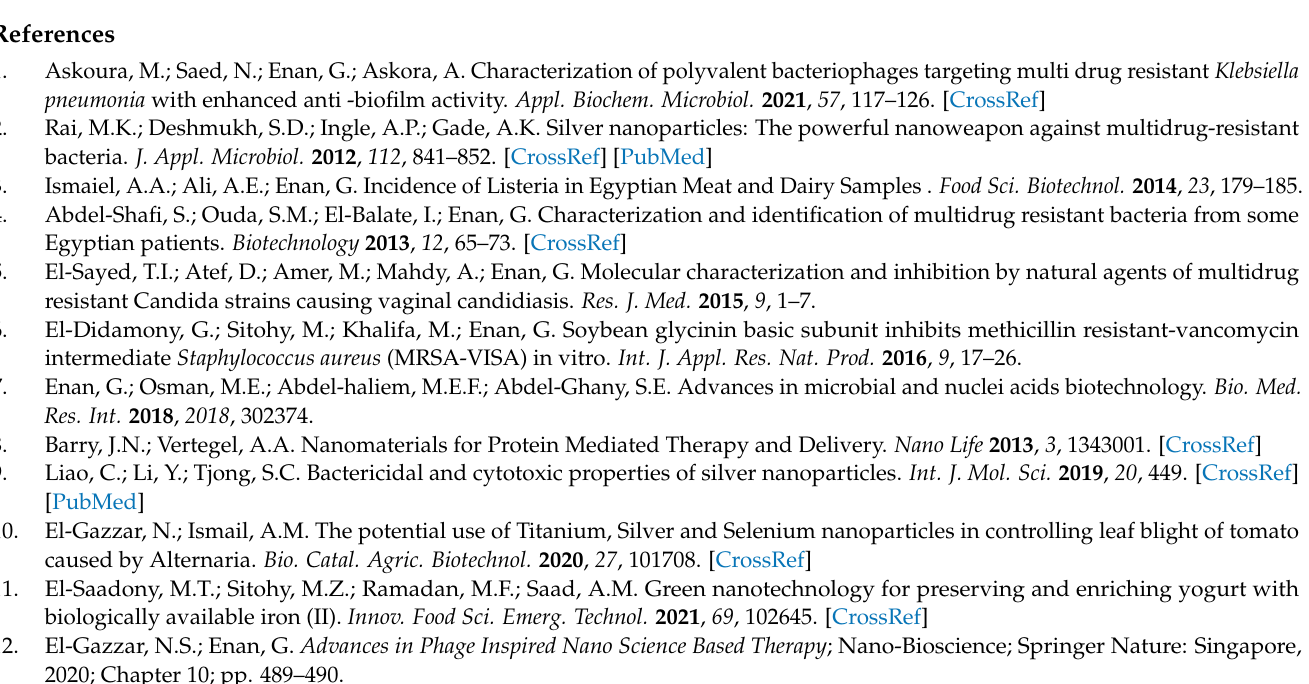
tary Figure S2. The isotherm curve of (A) FNP; (B) Ag-FNP; (C) MNP; (D) Ag-MNP. Supplementary Figure S3. Antibacterial activity of silver mung bean protein nanocomposite (Ag-MNP), and silver fenugreek protein nanocomposite (Ag-FNP) against Gram-positive and Gram-negative